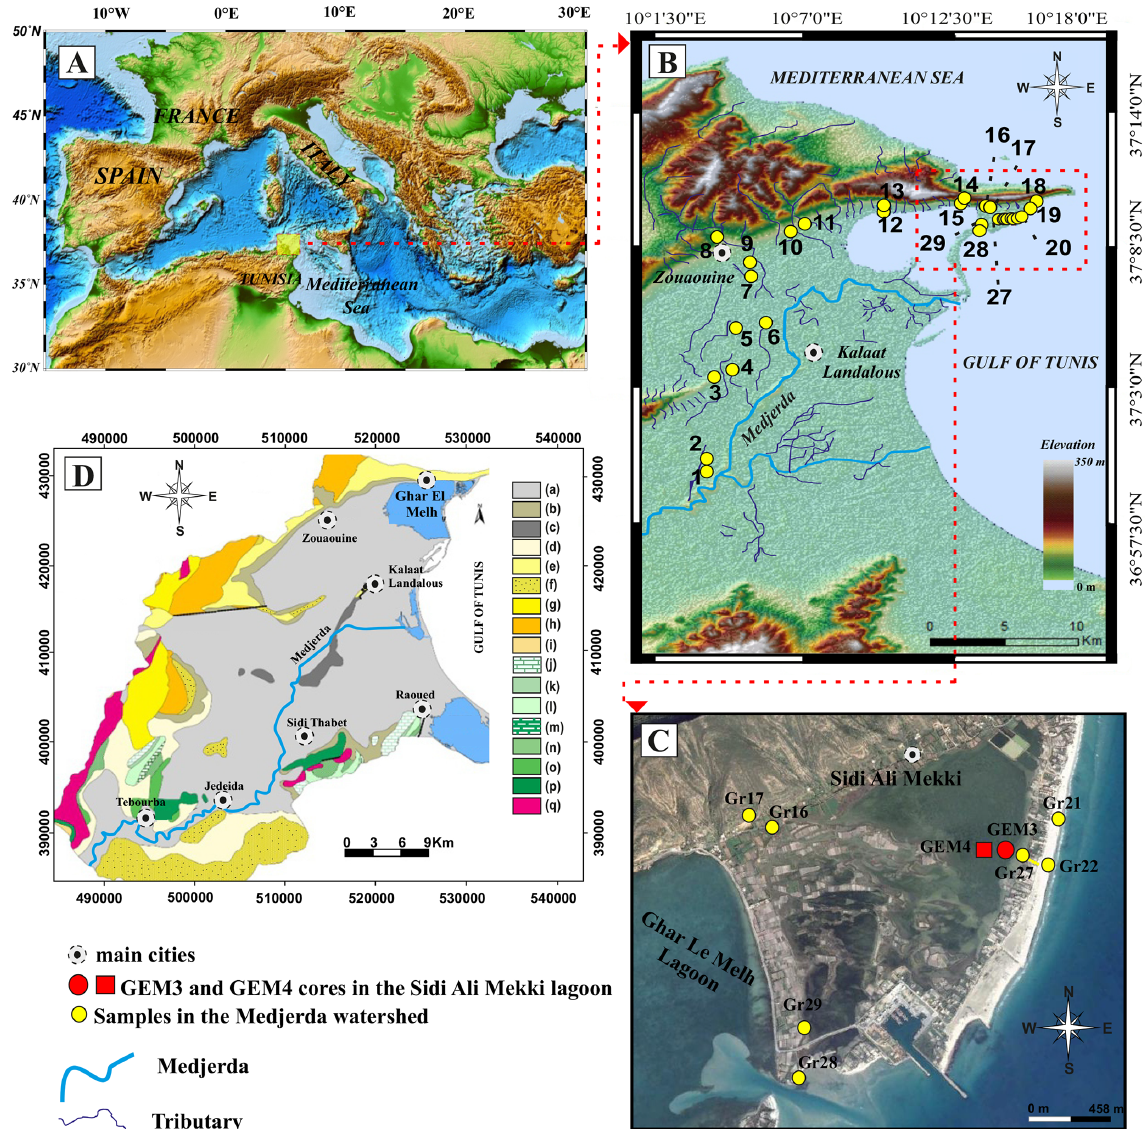
Figure 1. Maps of geographic setting of the Ghar El Meleh lagoon. (A) Position of the studied region in the northeastern Mediterranean (Word Ocean Atlas 2013, http://odv.awi.de/de/data/ocean/worldoceanatlas2013, last access: 1 December 2021). (B) Topographic map of the lagoon and the emplacement of the different surface sediment samples taken from the coastal plain of the Medjerda (created by Radewane Hout using ArcGIS). (C) Topographic map of the Ghar El Meleh lagoon and its surroundings (e.g., © Google Earth). (D) Geological maps of the Medjerda watershed – (a) recent alluvial soils, (b) slope deposits, (c) marine Quaternary, (d) Villafranchian, (e) Pliocene, (f) Continental Pliocene, (g) Upper Miocene, (h) detrital sediment deposit from Kchabta (i) Lower Eocene, (j) Maastrichtian, (k) Senonian, (l) Cenomanian, (m) Albian, (n) Aptian, (o) Barremian, (p) Valanginian–Hauterivian, (q) Triassic – (geological map; paper no. II of Bizerte at 1 : 200000 modified from Hamouda,